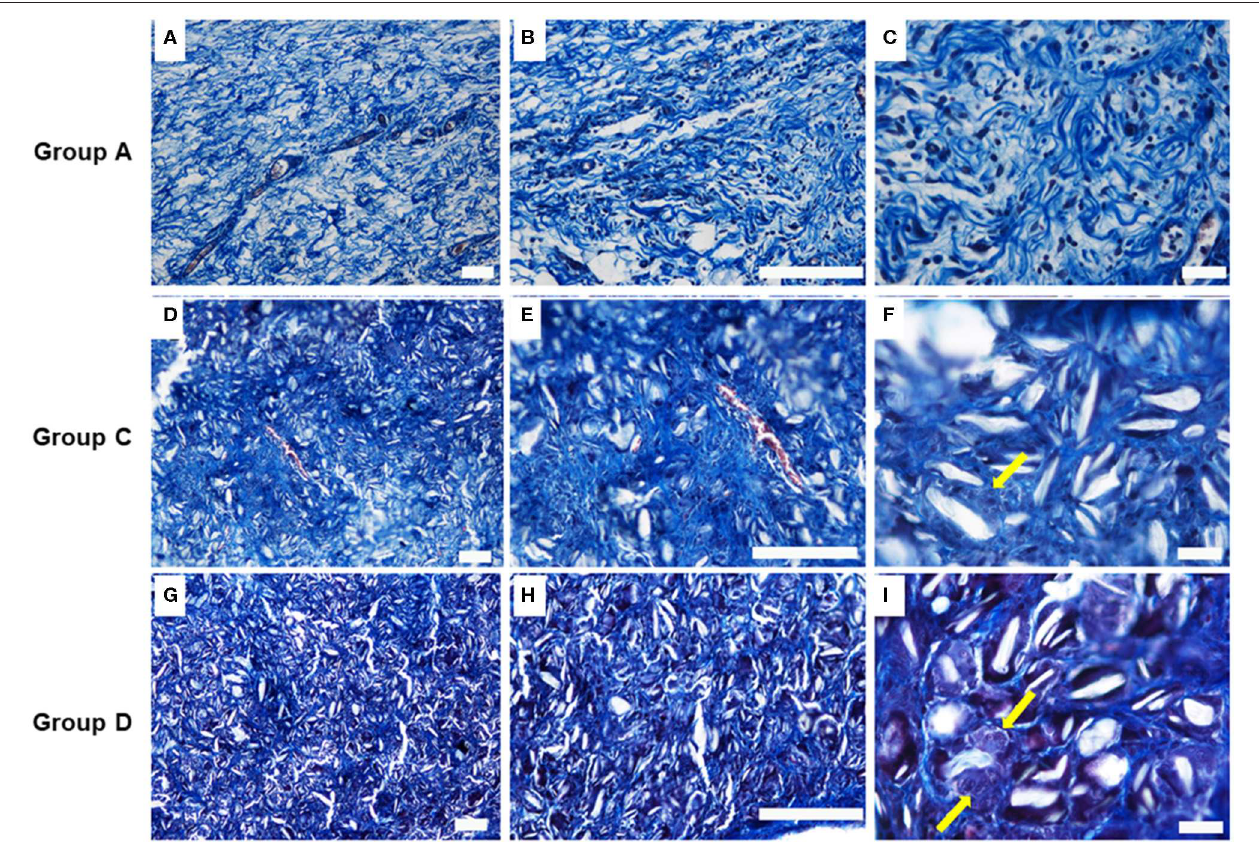
FIGURE 3 | Masson’s trichrome stain images on the samples at 4 weeks. (A–C) Group A: control lesions (Scale bars: a, b 100–c 20 µ m); (D–F) Group C: Lesions obtained by incision with injection of 160 mg/ml of talc (Scale bars: d, e 100–f 20 µ m); (G–I) Group D: Lesions obtained by incision with injection of 300 mg/ml of talc (Scale bars: g, h 100–i 20m). Note the presence at higher magnification, of multigiant cells (yellow